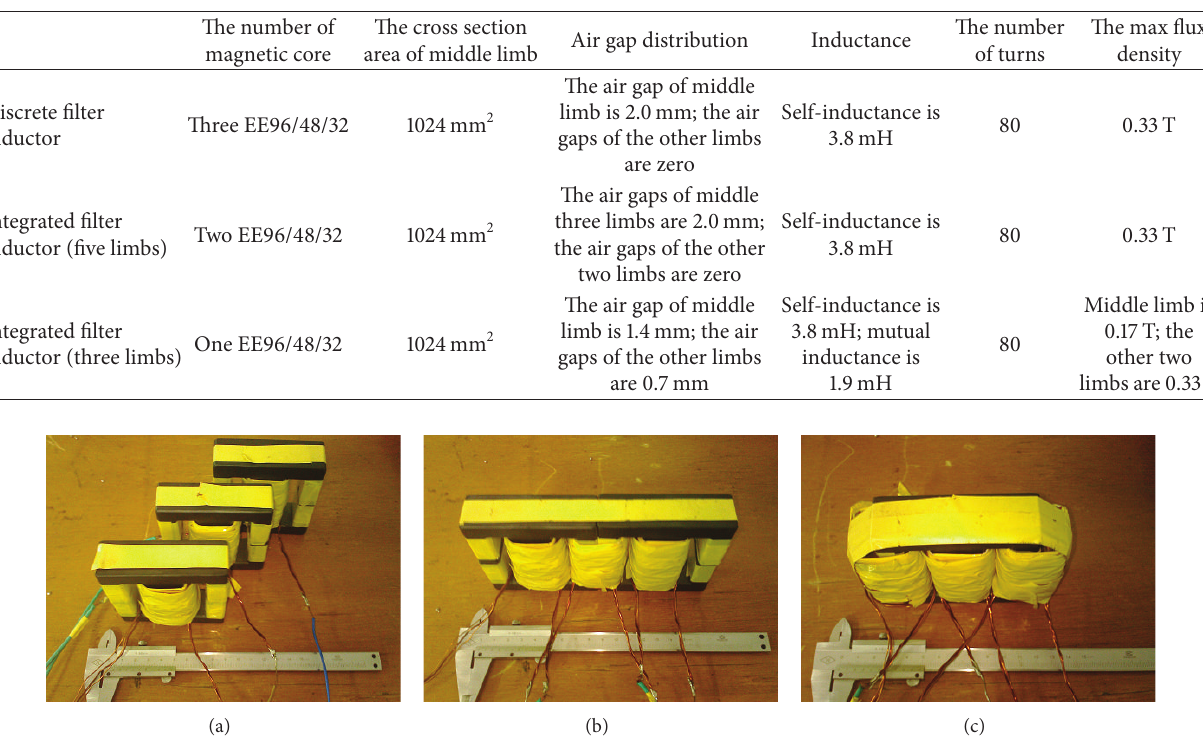
Table 2: The comparison of the discrete magnetics, five-limb magnetics, and three-limb magnetics.